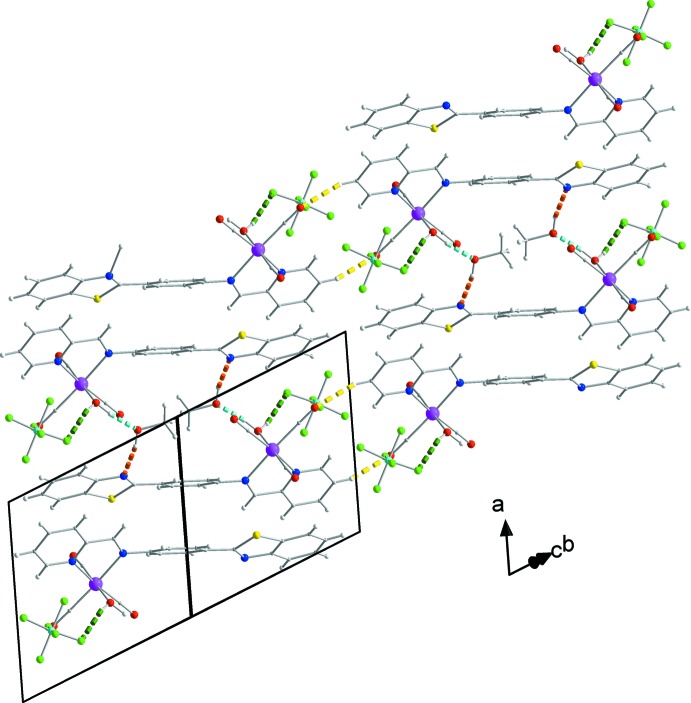
Layers of complexes parallel to (01). C5—H5⋯O2 hydrogen bonds are indicated by yellow dashed lines. For the atoms and the rest of the bonds, the colour code is as in Fig. 2 ▸.